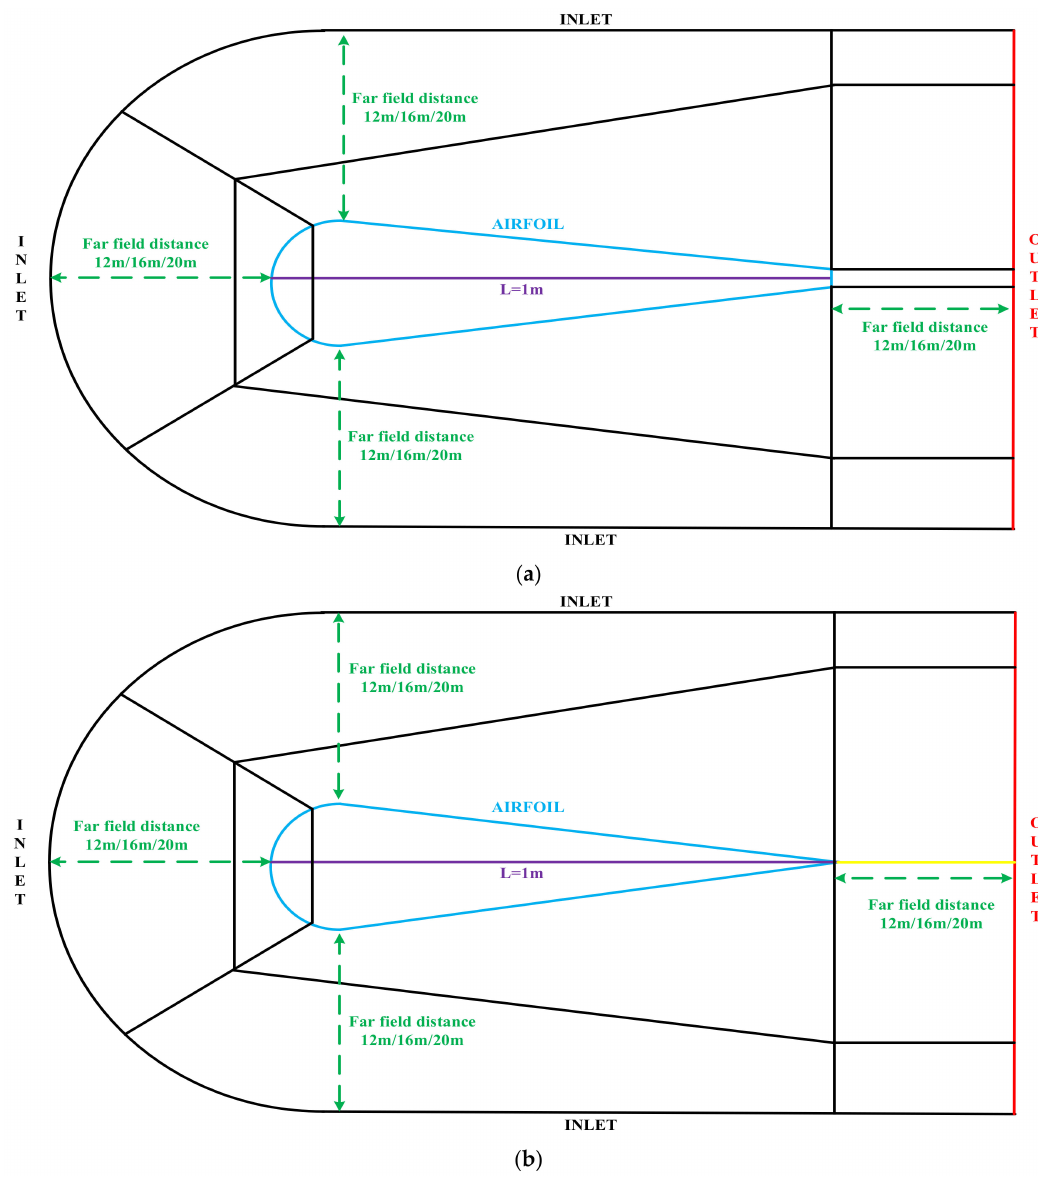
Figure 2. ( a ) Grid division of the blunt trailing edge; ( b ) grid division of the sharp trailing